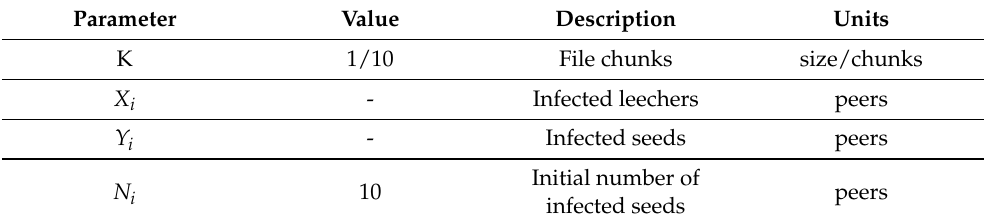
Table 3. Added parameters to the chain with infected